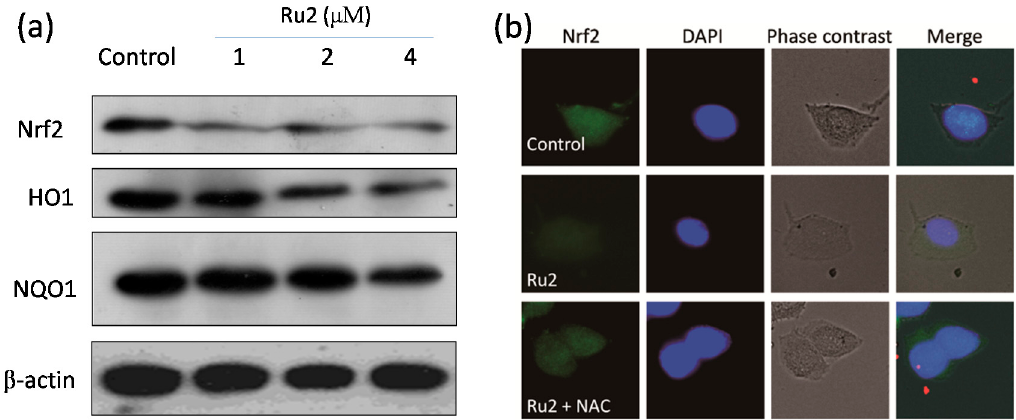
Figure 8. Regulation of Nrf2 pathway by Ru2 . ( a ) Effects of Ru2 on the expression levels of Nrf2, HO1, and NQO1 in HepG2 cells after treatments for 24 h; ( b ) Immuno-fluorescence of Nrf2 in cells treated with Ru2 for 24 h (magnification, 200×).